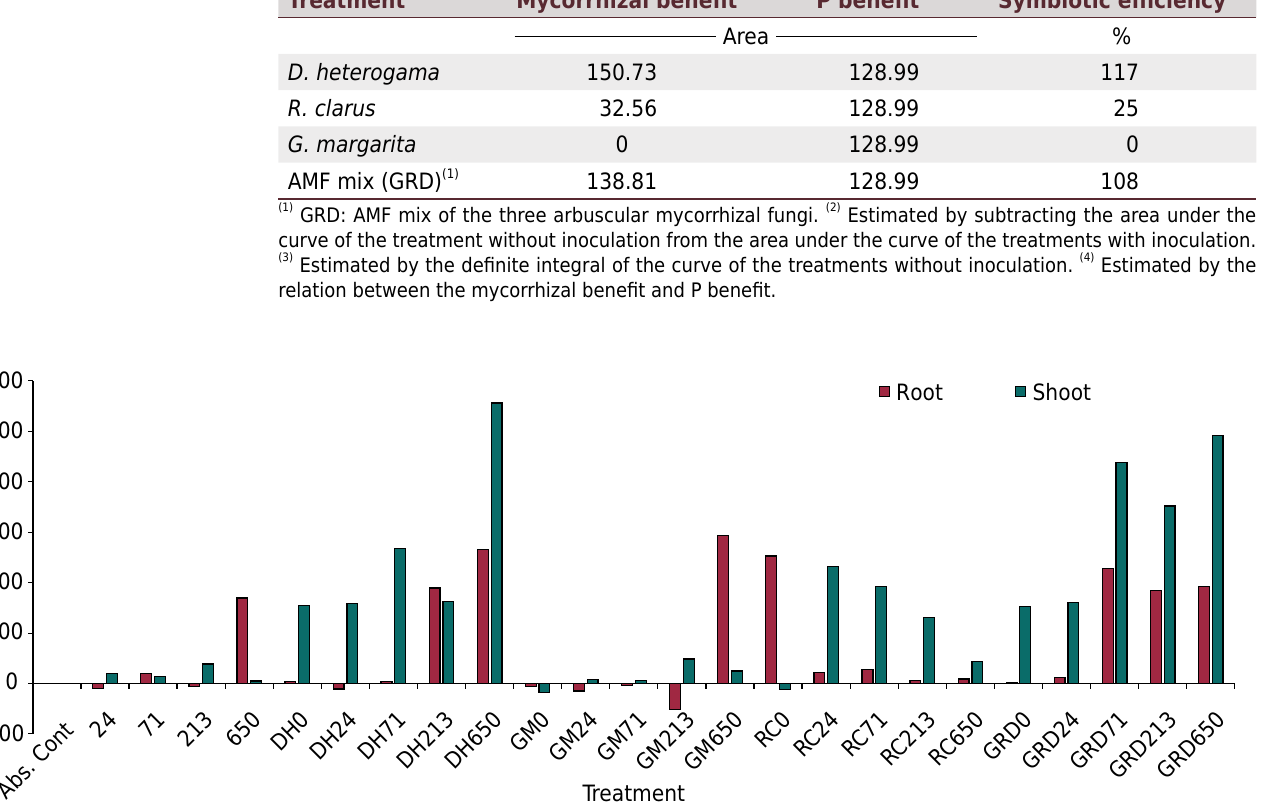
Table 1. Response of Apuleia leiocarpa to inoculation with different arbuscular mycorrhizal fungi (AMF) regarding mycorrhizal benefit, P benefit, and symbiotic efficiency, considering total plant